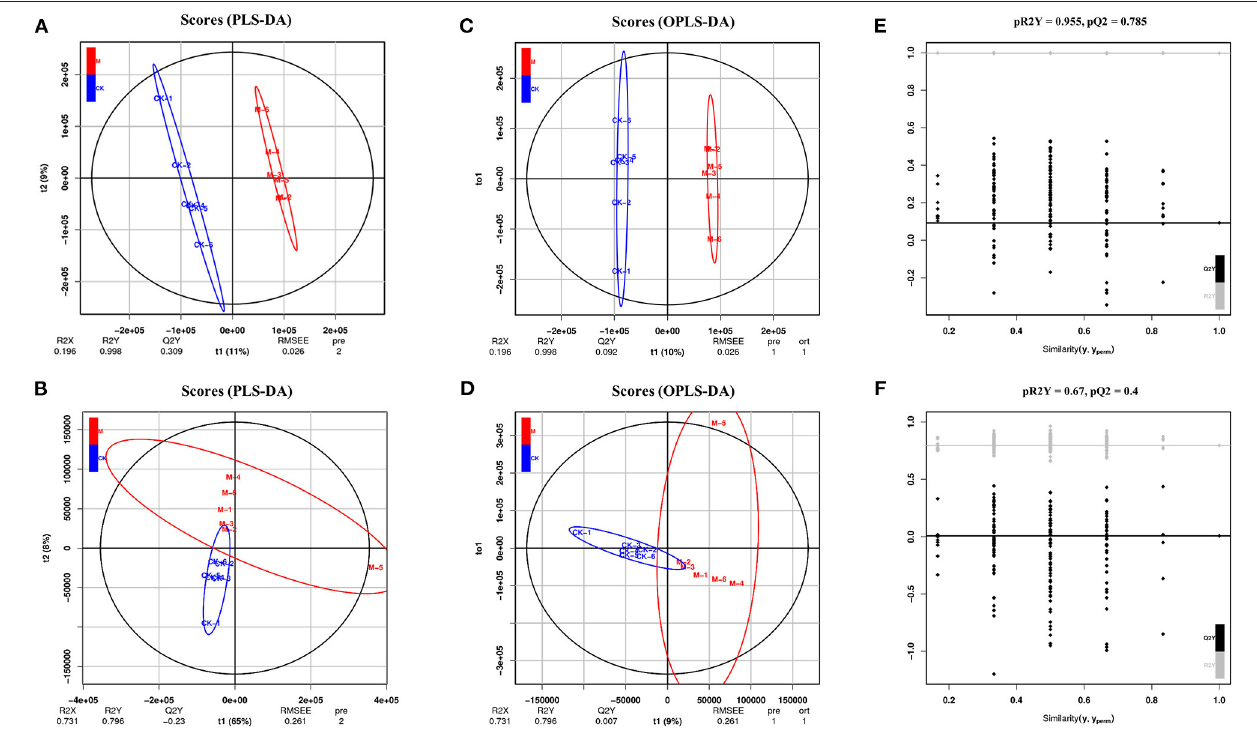
FIGURE 3 | Multivariate statistical analysis in positive and negative ion mode. (A) PLS-DA score charts in positive ion mode. (B) PLS-DA score charts in negative mode. (C) OPLS-DA score charts in positive ion mode. (D) OPLS-DA score charts in negative ion mode. (E) OPLS-DA model validation charts in positive ion mode. (F) OPLS-DA model validation charts in negative ion mode. n = 5–6 mice per group. CK, control check; M, model group [All R2 ′ and Q2 ′ points from left to right were lower than rightmost two points ( x = 1.0) (R2 and Q2 of the original model)]; this indicated that the model was robust and reliable without overfitting.